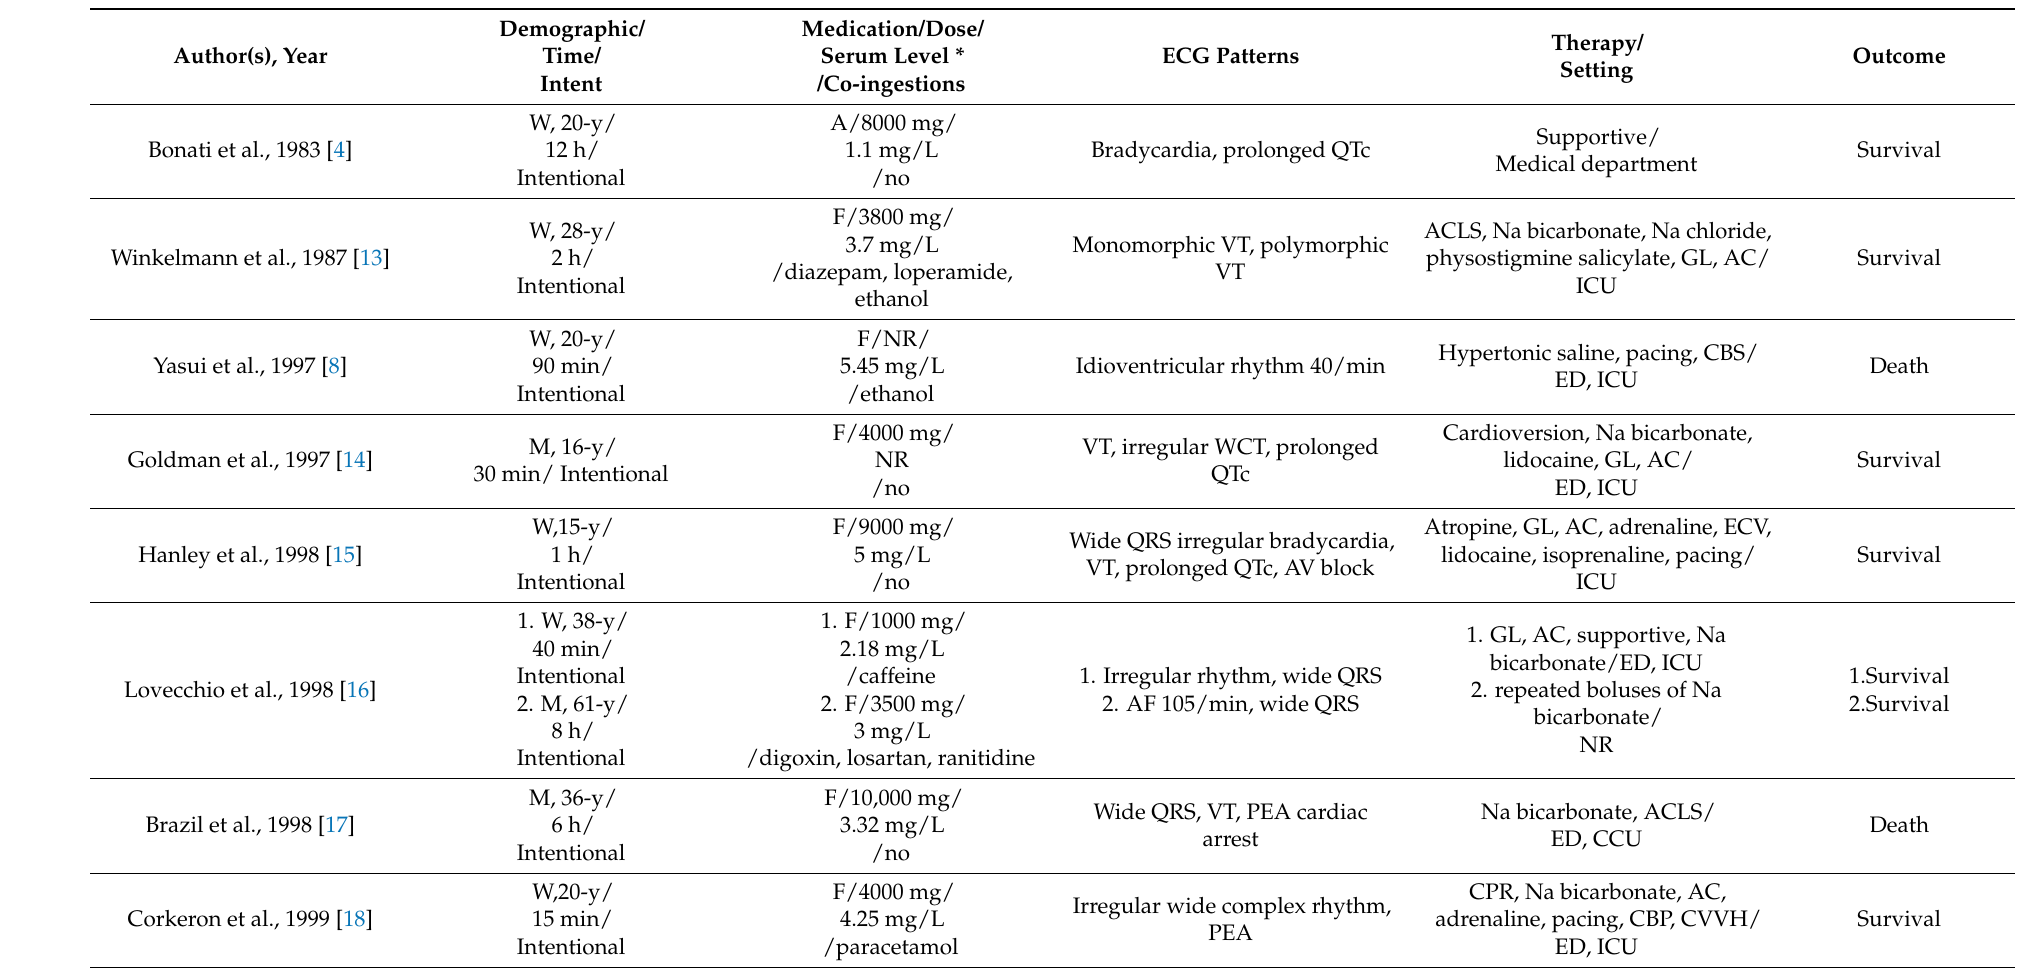
Table 2. Characteristics and main findings of eligible